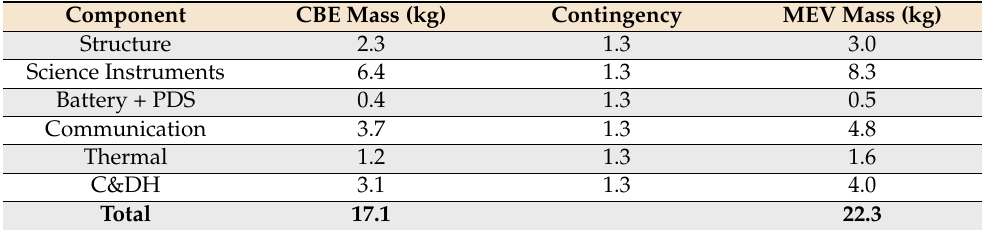
Table 6. Mass breakdown of the VLF Habitability Mission parachute probe concept.